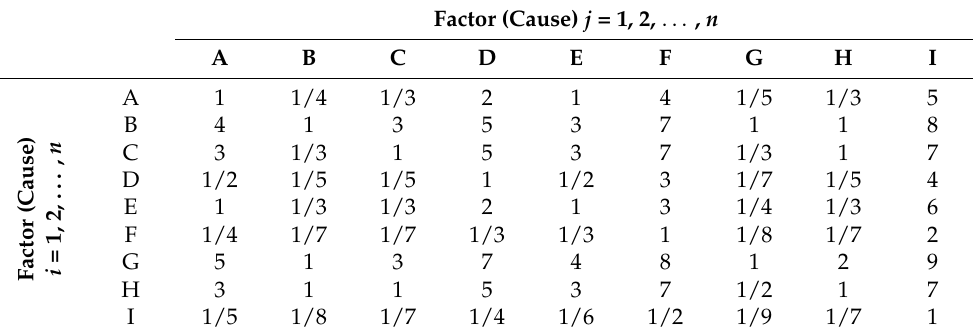
Table 4. The pairwise comparison matrix for identifying the significance (importance) of the criteria for purchasing a new AMP.